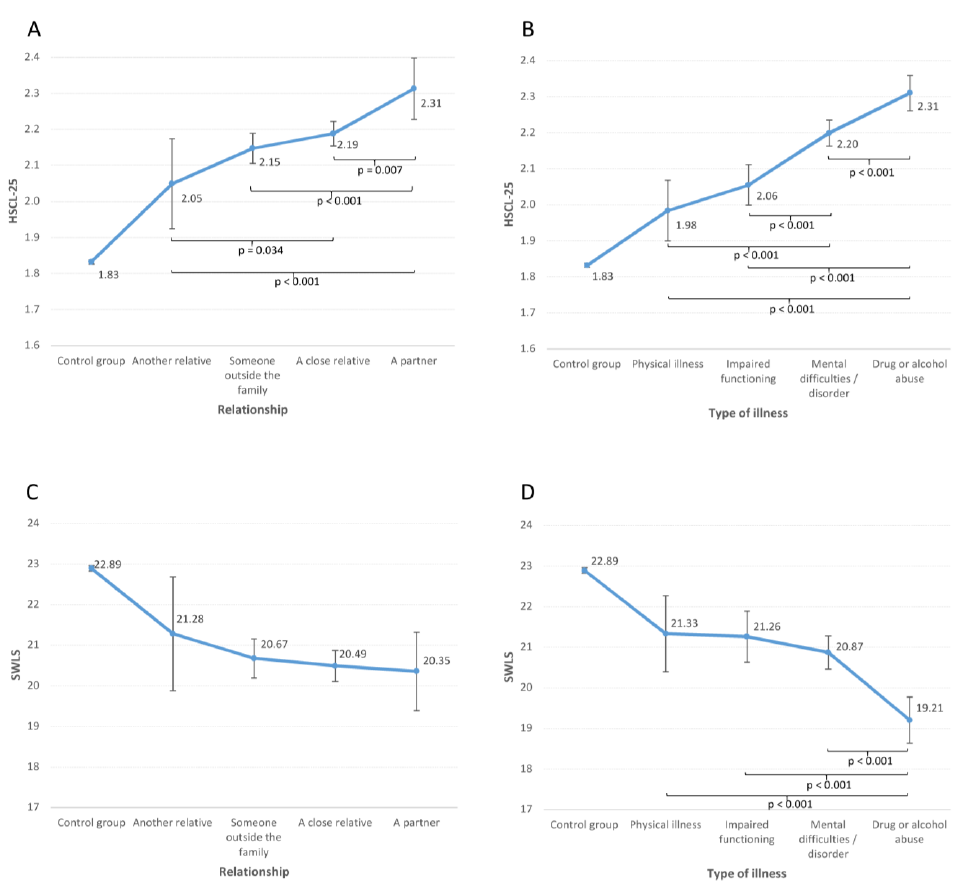
Figure 2. Mental health problems (HSCL-25) and life satisfaction (SWLS) by type of relationship between YACs and care-receiver ( A , C ) and type of illness in care-receiver ( B , D ). As shown in Figure 2B, caring for a person affected by drug or alcohol abuse was associated with the highest level of mental health problems among the carer, whereas car- ing for a person with a physical illness was associated with the lowest level of mental health problems. However, all four groups of carers had significantly worse mental health compared to students without care responsibilities (all p s < 0.001). The opposite pattern was observed when investigating life satisfaction as the outcome variable. As detailed in Figure 2D, those caring for a person with drug or alcohol abuse had the lowest life satis- faction compared to all other carers. No other significant group differences were observed, although all four groups of carers scored significantly lower compared with students without care responsibilities (all p s < 0.001). The patterns were similar for both men and women, and there were no significant gender interactions for any of the analyses. 3.4. Hours of Daily Care